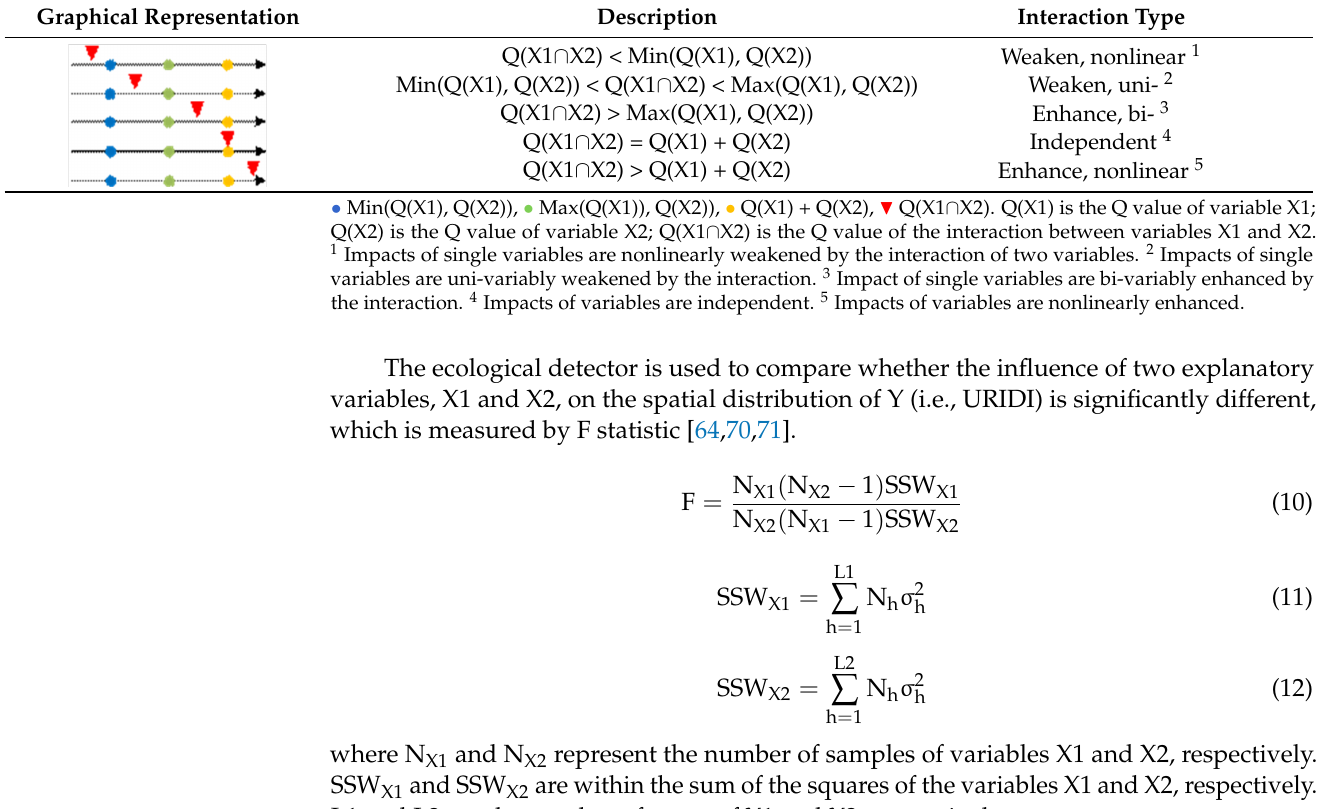
Table 3. Types of interaction between two variables. Graphical